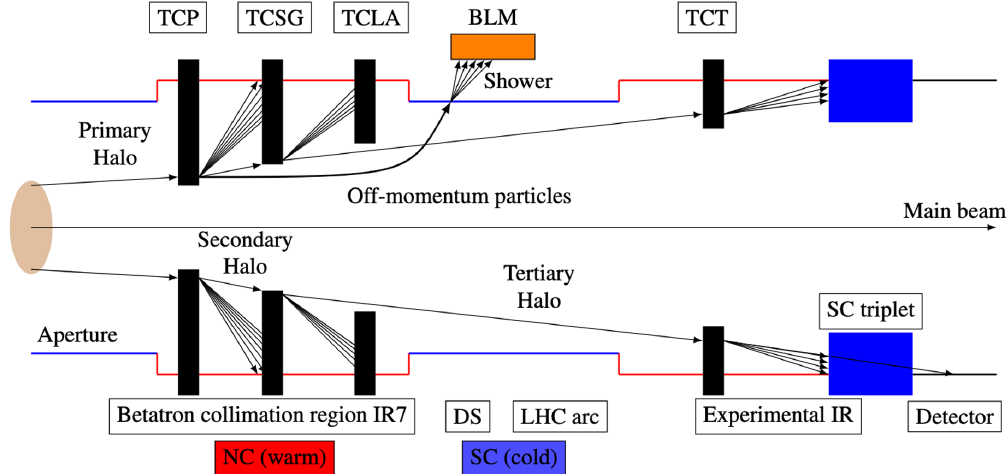
FIG. 1. LHC multistage collimation system scheme where the different collimator families are indicated. Normal conducting (NC) and superconducting (SC) apertures are depicted in red and blue, respectively